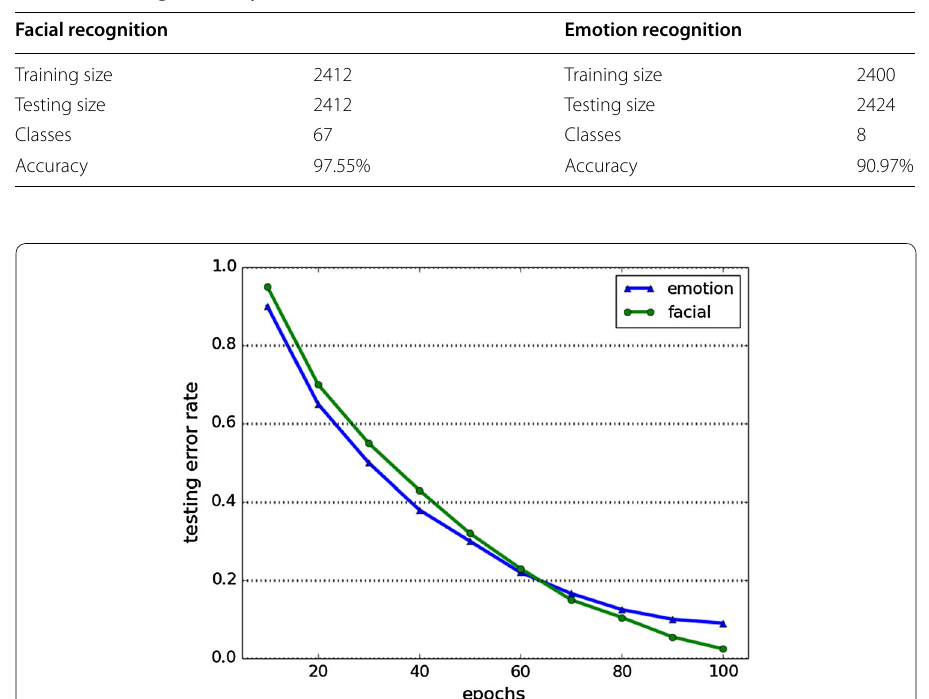
Fig. 5 Error rate of the